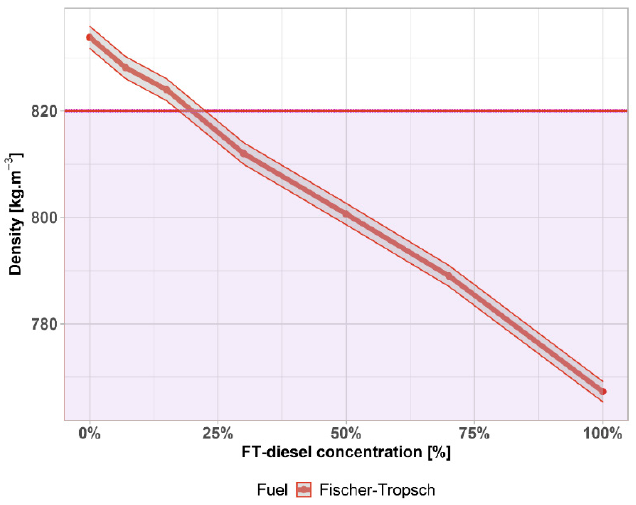
Figure 6. Density of FT − diesel mixtures.